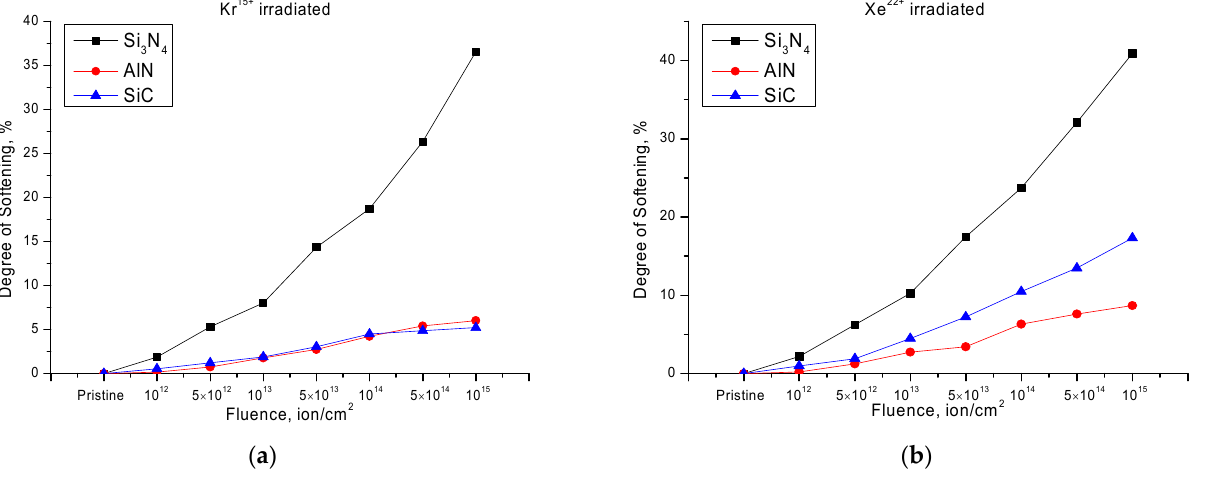
Figure 2. The results of changes in the softening degree of the damaged layer of the investigated ceramics depending on the type of incident ions: ( a ) irradiation with Kr 15+ ions; ( b ) irradiation with Xe 22+ ions.